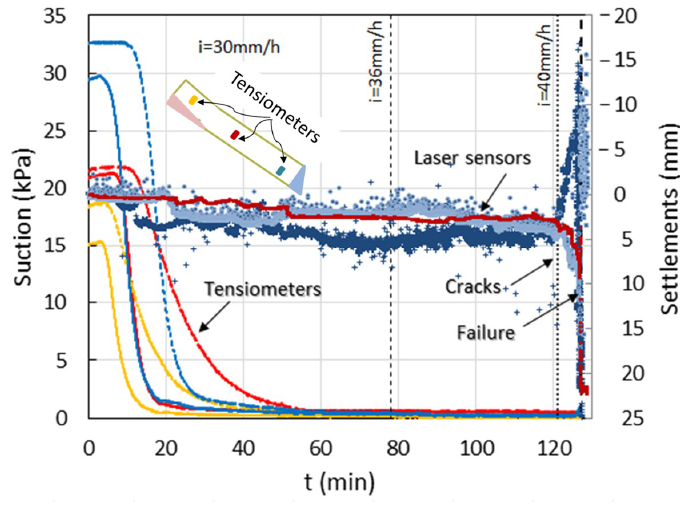
Figure 9. Suction and settlements measured in the RP3 experiment.